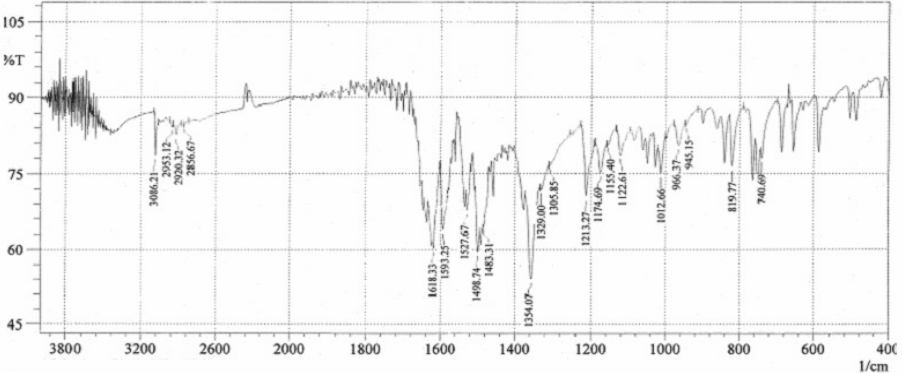
Figure 4. FT IR spectra of